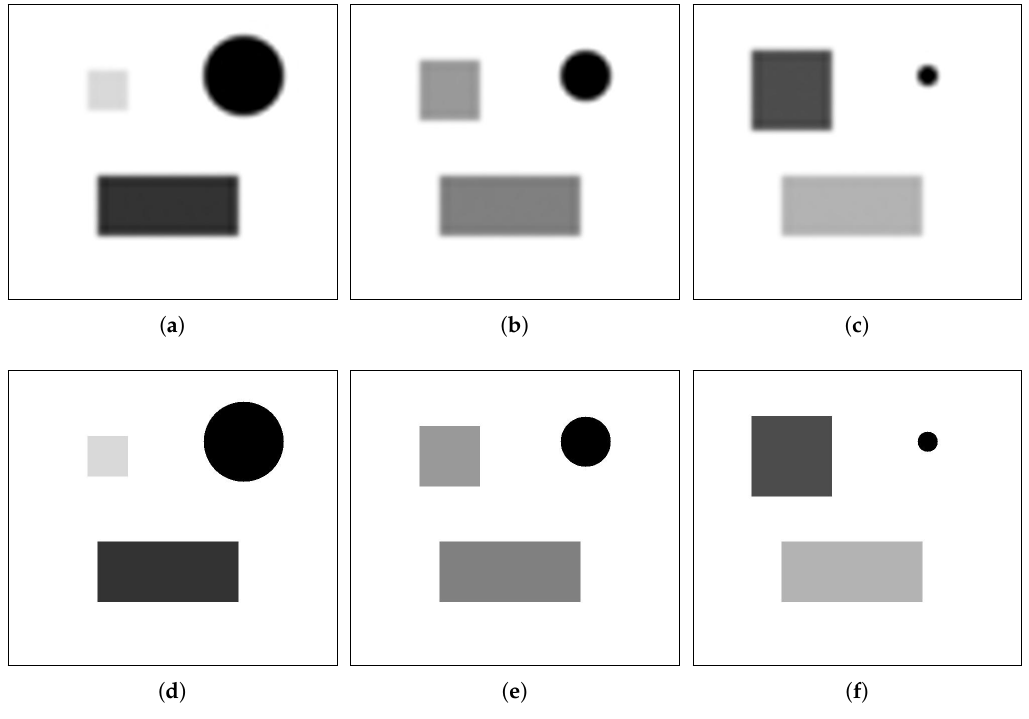
Figure 6. Simulated images: ( a ) MODIS-like image at t 1 ; ( b ) MODIS-like at t 2 ; ( c ) MODIS-like at t 3 ; ( d ) Landsat-like at t 1 ; ( e ) Landsat-like at t 2 ; and ( f ) Landsat-like at t 3